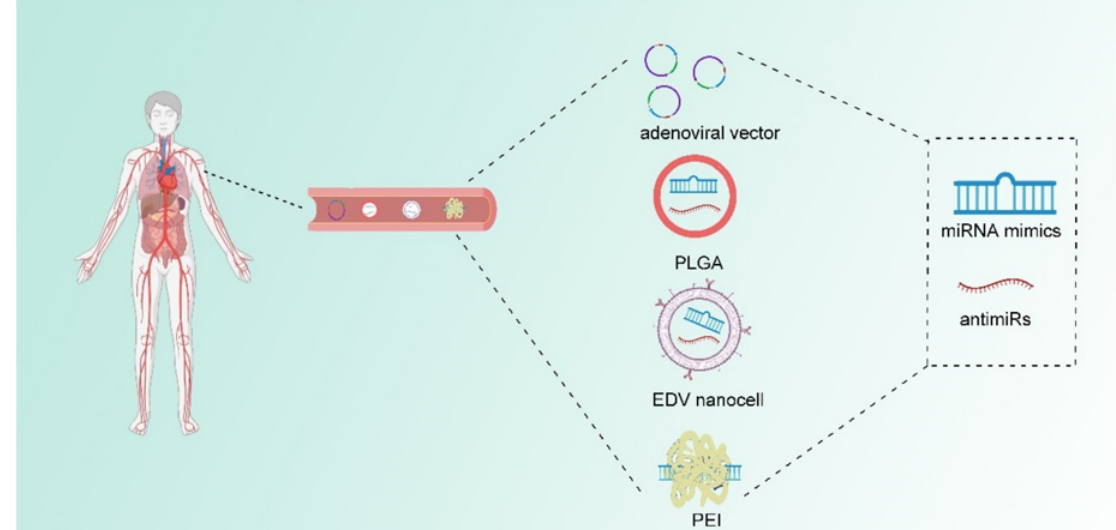
Figure 3. Chemical modifications and delivery system of miRNA in vivo application. The chemical modifications of miRNA mimics and antimiRs increase their stability to ensure the integrality of miRNA-based therapeutic particles, while development of delivery systems facilitates the efficiency of miRNA therapy in vivo. Some of the commonly used delivery vehicles includes adenoviral vector, Poly (lactide-co-glycolide) (PGLA), EnGeneIC Delivery Vehicle (EDV) nanocells and polyethylenimine (PEI) molecules. Safety issue as well as tumor-specific delivery systems are still tested in animal models and clinical